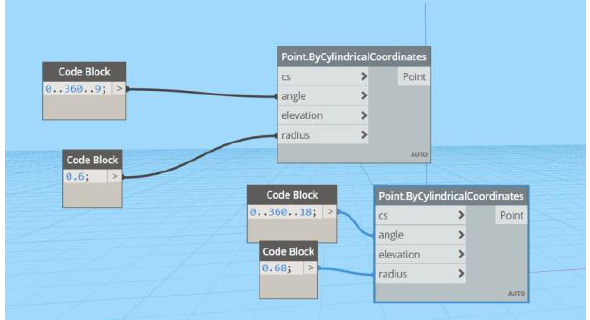
Figure 5. Dynamo workflow. (source: Kontoudaki, 2021)